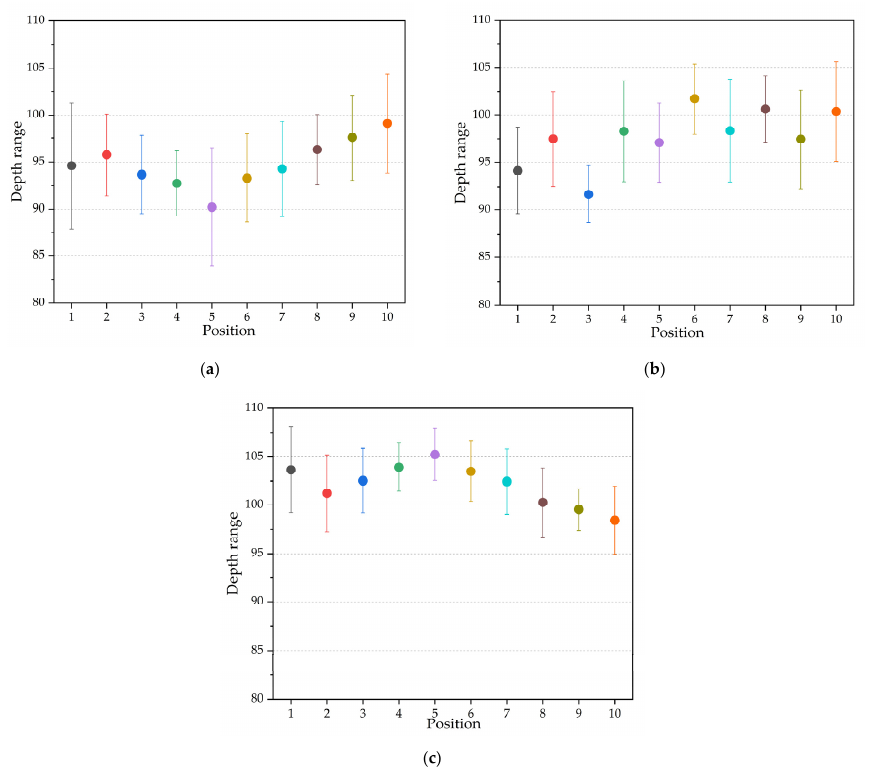
Figure 5. Replication depth: ( a ) the cavity thickness is 0.3 mm; ( b ) the cavity thickness is 0.5 mm; and ( c ) the cavity thickness is 0.7 mm. By comparing the distribution of the microstructure replication depth, we can see that the replication depth of the parts with a cavity thickness of 0.7 mm is generally higher than the parts with a cavity thickness of either 0.3 mm or 0.5 mm. The results indicate that increasing the thickness of the cavity can promote replication depth. By comparing the fluctuation range of the replication depth at the same position under different thicknesses, we were able to ascertain that, with the increase in the cavity thickness, the influence of the process parameters on the replication depth of a single position is weakened. 3.3. Effects of Cavity Thickness on Replication Uniformity 3.3.1. Effects of Cavity Thickness on Uniformity of Each Position To explore the replication uniformity of the microstructure depth, Figure 6 is plotted according to the result calculated by Equation (1).